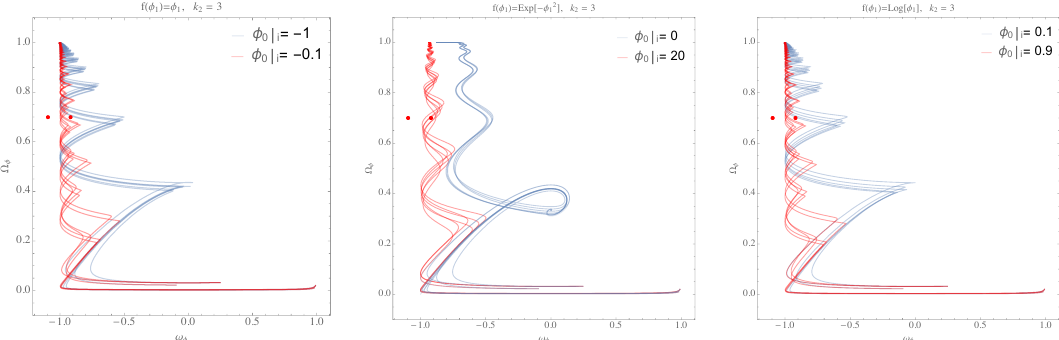
Figure 2 . ((cid:10) (cid:30) ; ! (cid:30) ) plane evolution for matter dominated initial conditions and k 2 = 3. Trajectories that seem to end at without passing through should be considered as a numerical S NG